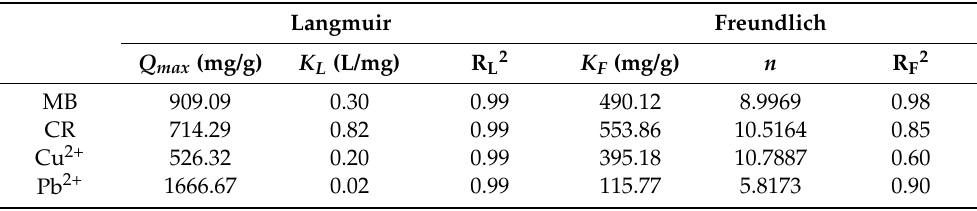
Table 3. Adsorption isotherm parameters for dyes metal ions on the